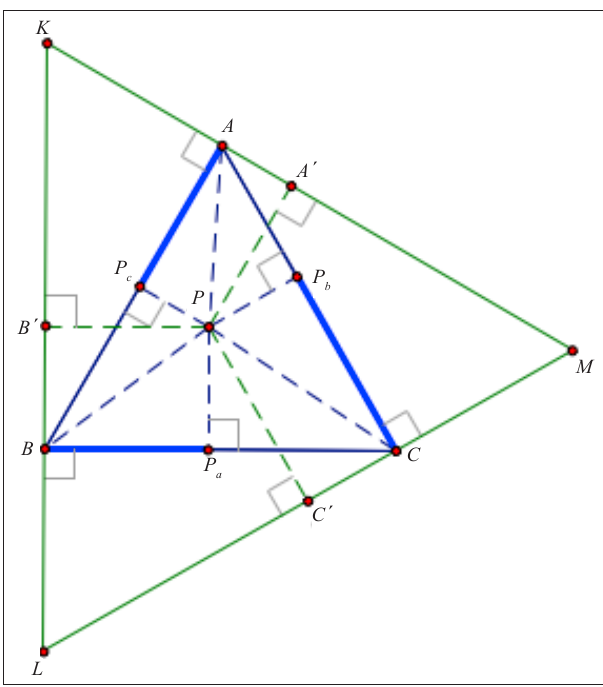
FIGURE 2: A geometric proof of Clough’s conjecture. FIGURE 3: An alternative, algebraic proof of Clough’s